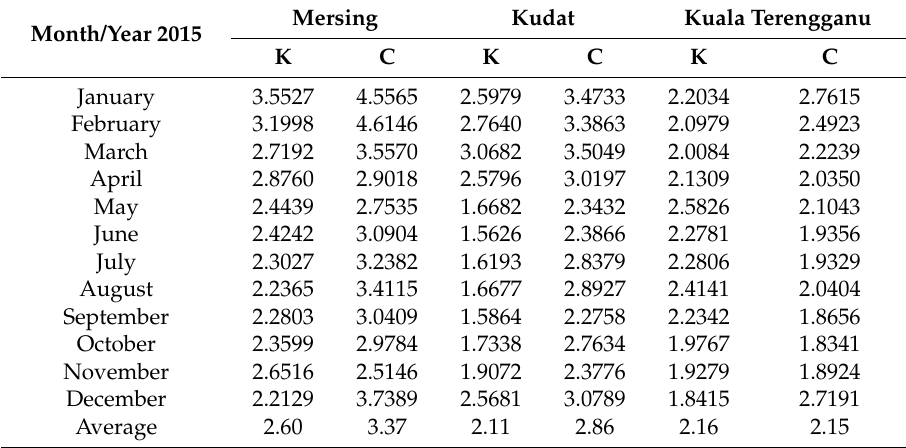
Table 3. The values of the Weibull parameter estimation by Empirical Method at Mersing, Kudat, and Kuala Terengganu based on hourly wind speed data for the year